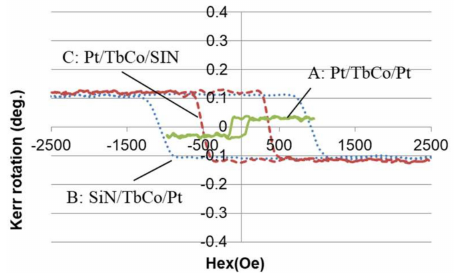
Figure 2. Polar Kerr hysteresis loops of the samples measured with a wavelength of 500nm. A: Pt(3 nm)/TbCo(6 nm)/Pt(3 nm), B: Si 3 N 4 (10 nm)/TbCo(6 nm)/Pt(3 nm), C: Pt(3 nm)/TbCo (6 nm) /Si 3 N 4 (10 nm).